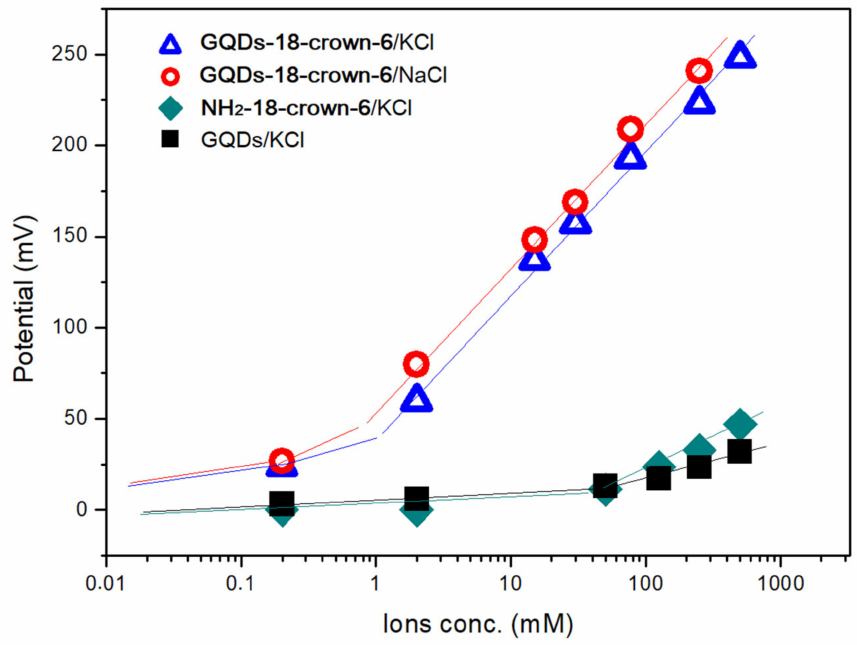
Figure 4. Comparison of the electrochemical response for GQDs-18-crown-6/SPCE, towards K + and Na +